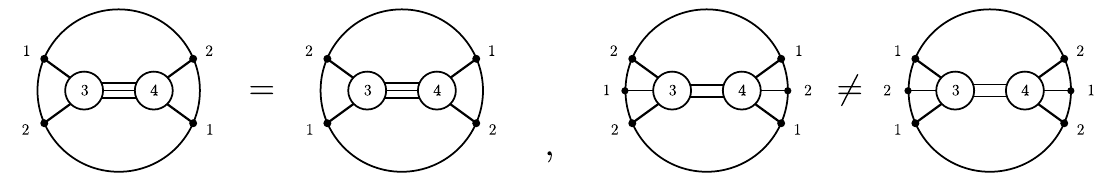
Figure 46 . For even ‘ , the diagrams that are related by the permutation of 1 and 2 give the same contribution while for odd ‘ they are